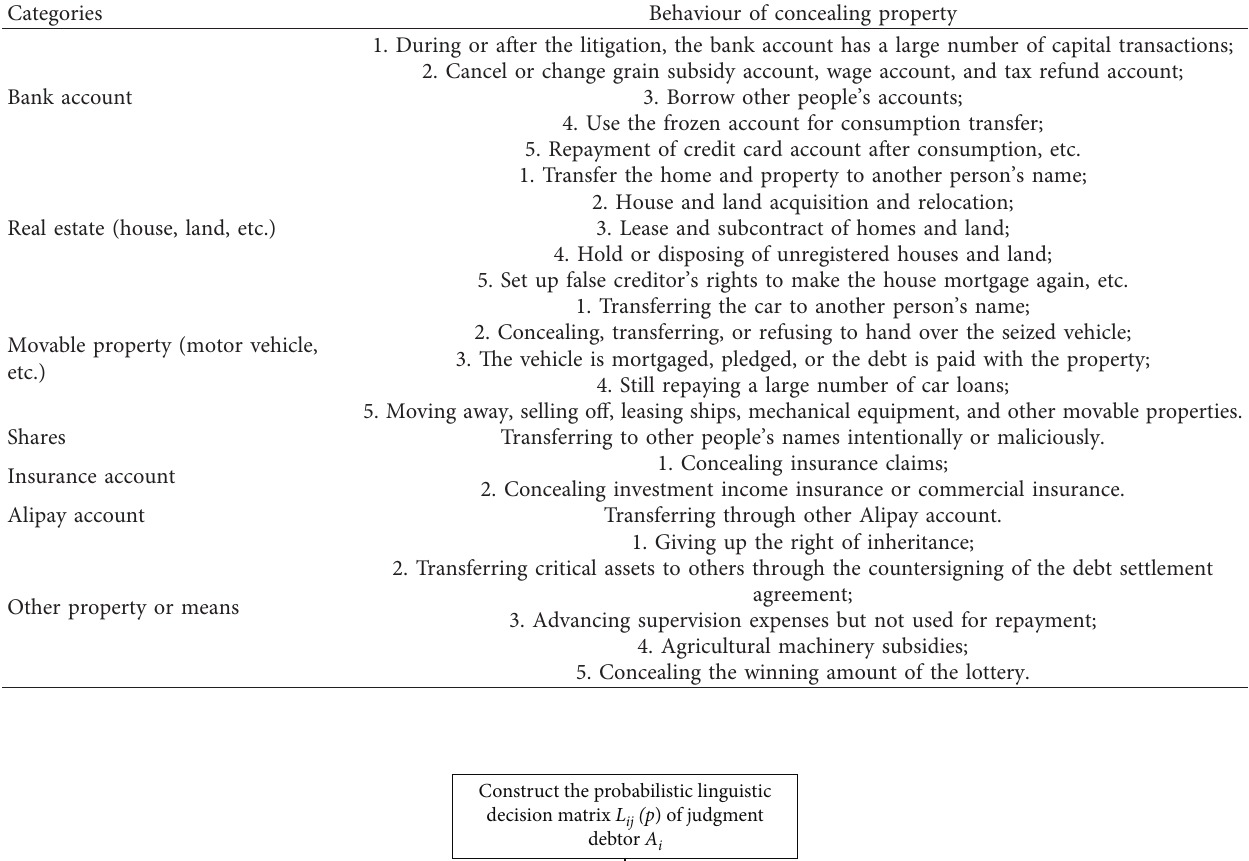
Table 3: Summary of concealing property